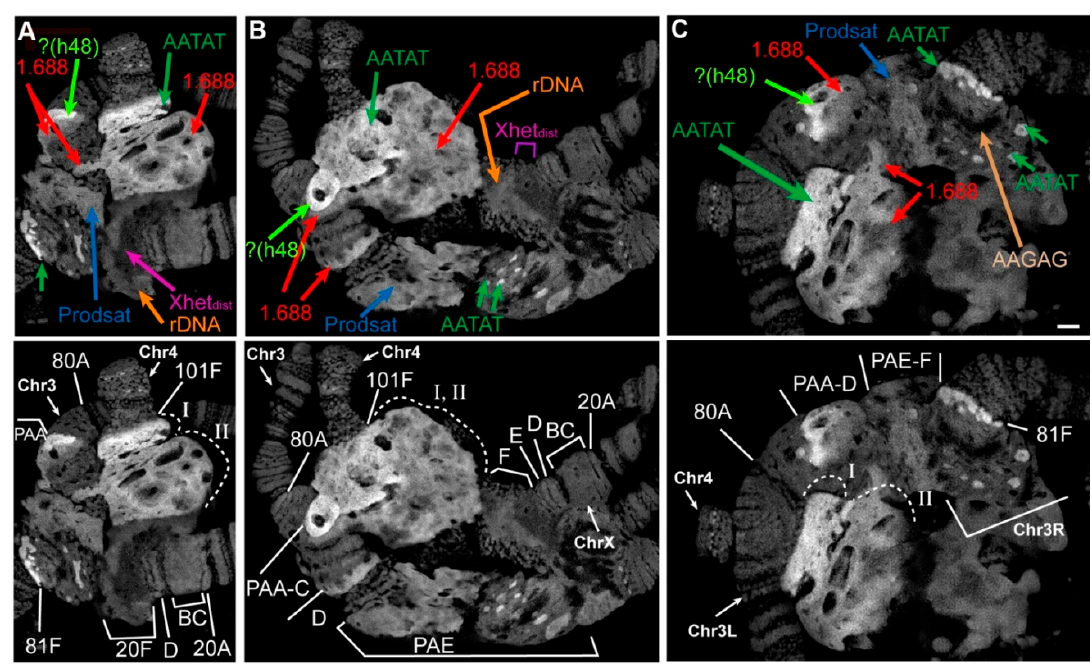
Figure 7. DAPI di ff erentially stains di ff erent types of DNA sequences in the heterochromatin of Rif1 polytene chromosomes. Optical sections (3D-SIM) of the pericentromeric regions of Rif1 1 /Rif2 2 polytene chromosomes stained with DAPI. Panels ( A – C ) depict three polytene nuclei. The lower row indicates the names of the morphological structures and the upper row shows the correspondence of these zones with di ff erent types of DAPI staining to heterochromatin blocks of di ff erent DNA composition. Each type of sequence is denoted by a separate color matching among panels ( A – C ).